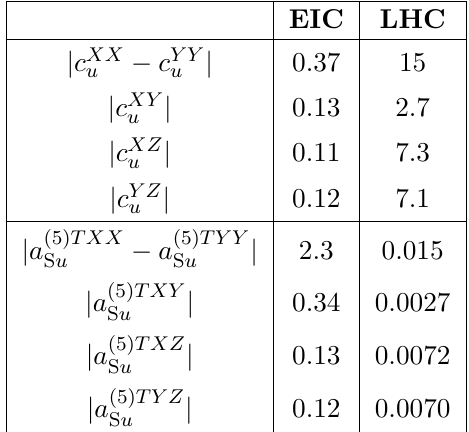
Table 4 . Comparison of estimated attainable sensitivities to equivalent u -quark coe(cid:14)cients at the EIC and the LHC. Values are in units of 10 (cid:0) 5 and 10 (cid:0) 6 GeV (cid:0) 1 for the minimal and nonminimal coe(cid:14)cients, respectively.